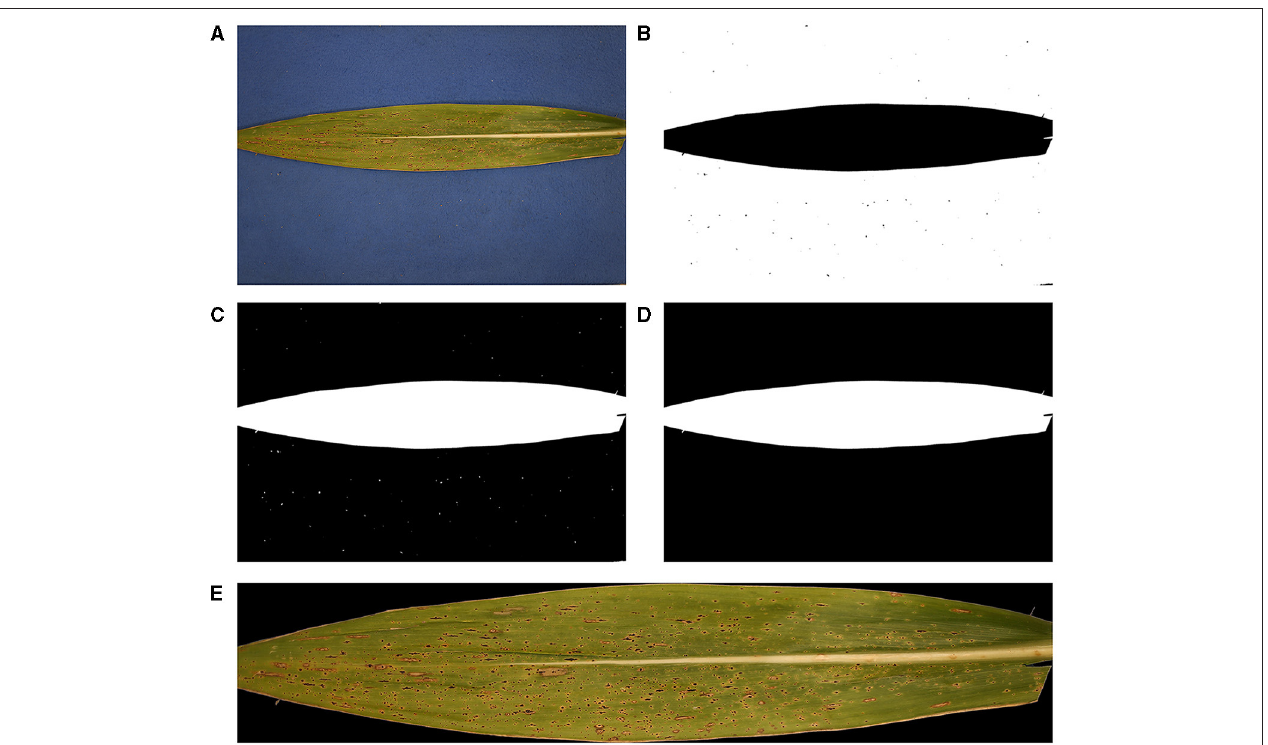
FIGURE 1 | Pre-processing of original tar spot-infected leaf images. (A) Original RGB image, (B) binary image after thresholding, (C) complement of the binary image, (D) resultant mask, and (E) cropped sample image after isolating the region of interest (RoI) (leaf image without background).